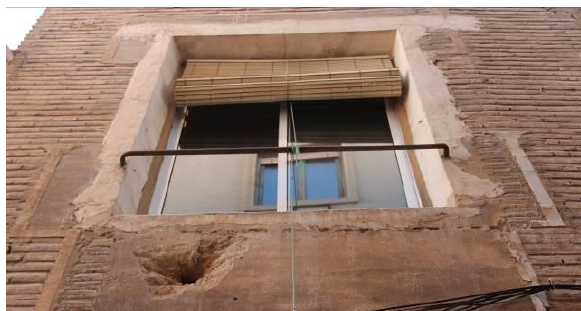
Figure 16. Mixed rammed earth wall on calle Caño no. 17 (Source: